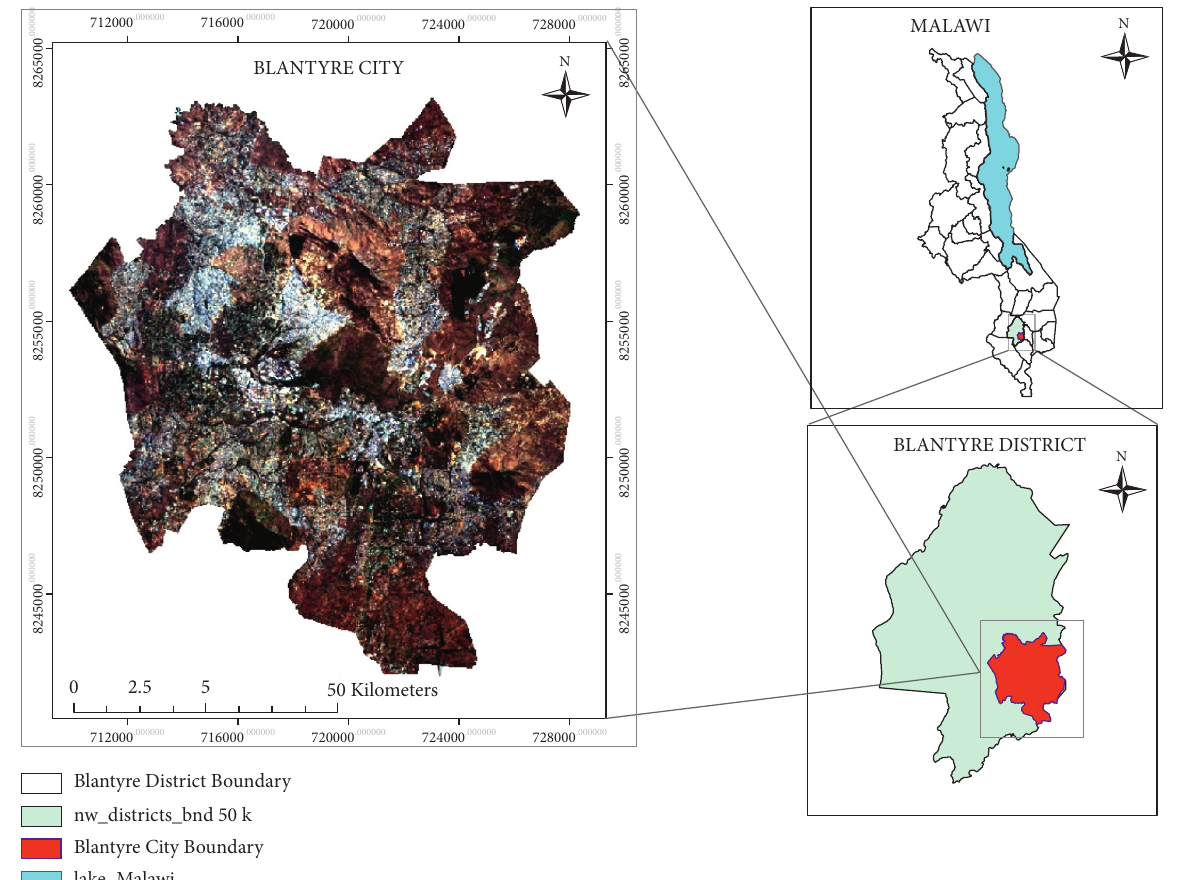
Figure 1: Location of the study area, Blantyre City. Data source: Diva GIS website and satellite image courtesy of the US Geological Survey